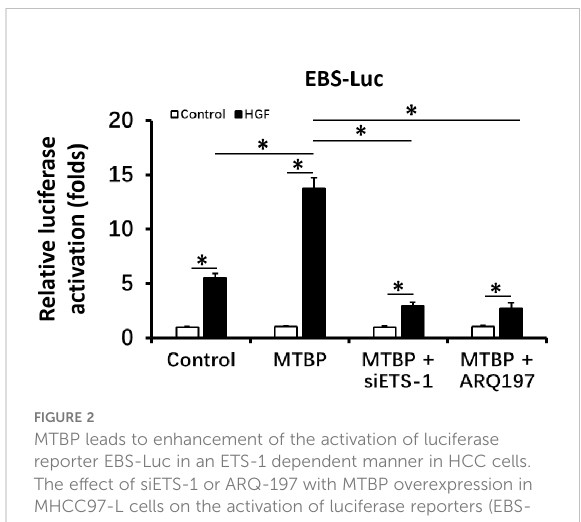
FIGURE 2 MTBP leads to enhancement of the activation of luciferase reporter EBS-Luc in an ETS-1 dependent manner in HCC cells. The effect of siETS-1 or ARQ-197 with MTBP overexpression in MHCC97-L cells on the activation of luciferase reporters (EBS- Luc) induced by HGF. *P <